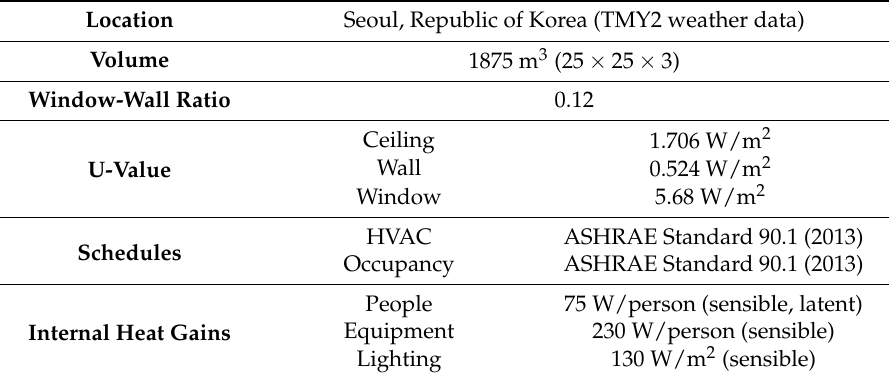
Table 2. Model building parameters [2].